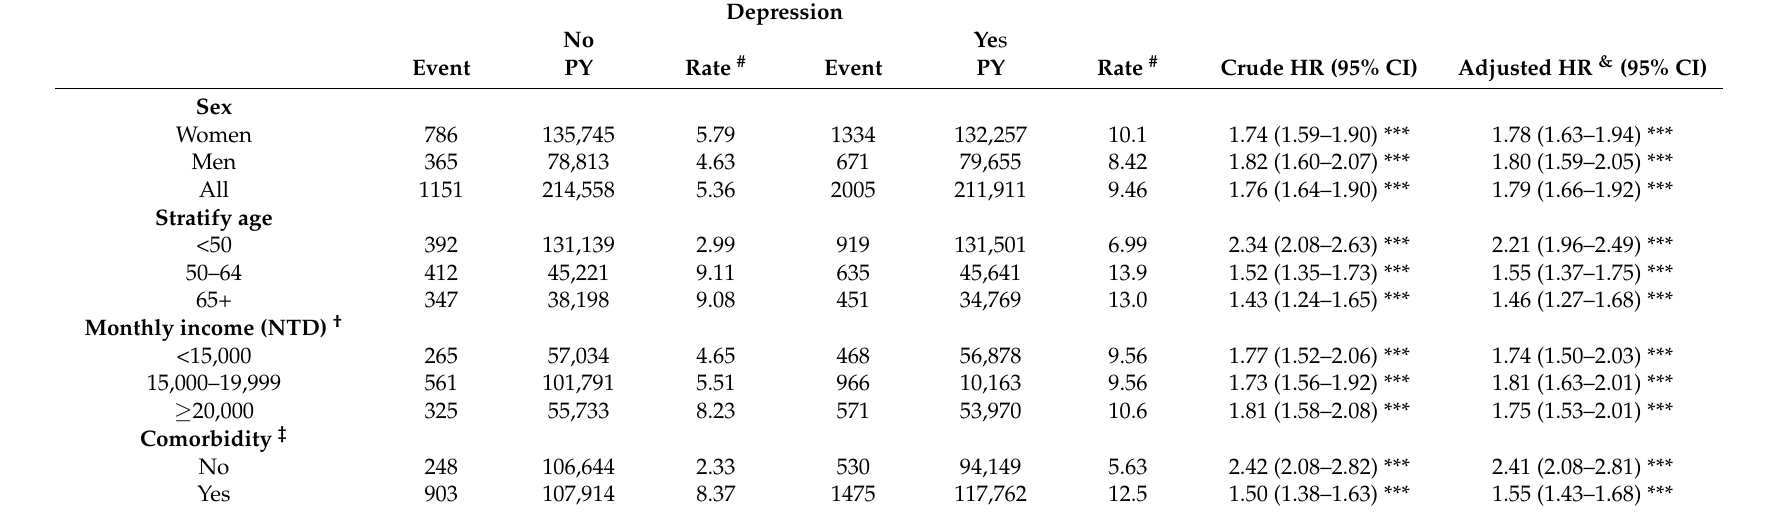
Table 2. Incidence densities and hazard ratio of cervical spondylosis by demographic characteristics and